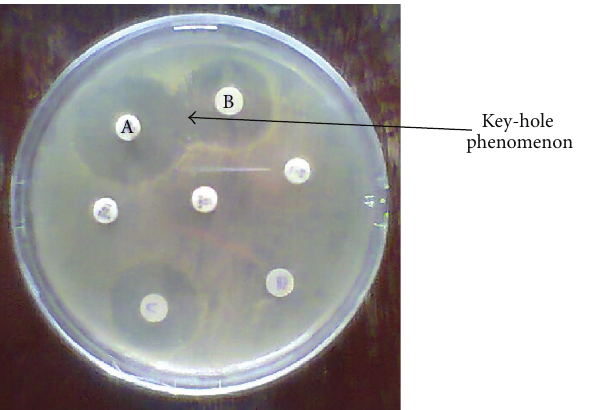
Figure 1: Culture plate showing synergy of clavulanic acid contain- ing disk with ceftazidime in the double disk synergy test (DDST) for ESBL detection. A is augmentin + ceftazidime. B is ceftazidime alone. Zone of inhibition of A − zone of inhibition of B ≤ 5 mm; it is ESBL negative. Zone of inhibition of A − zone of inhibition of B ≥ 5 mm; it is ESBL positive.